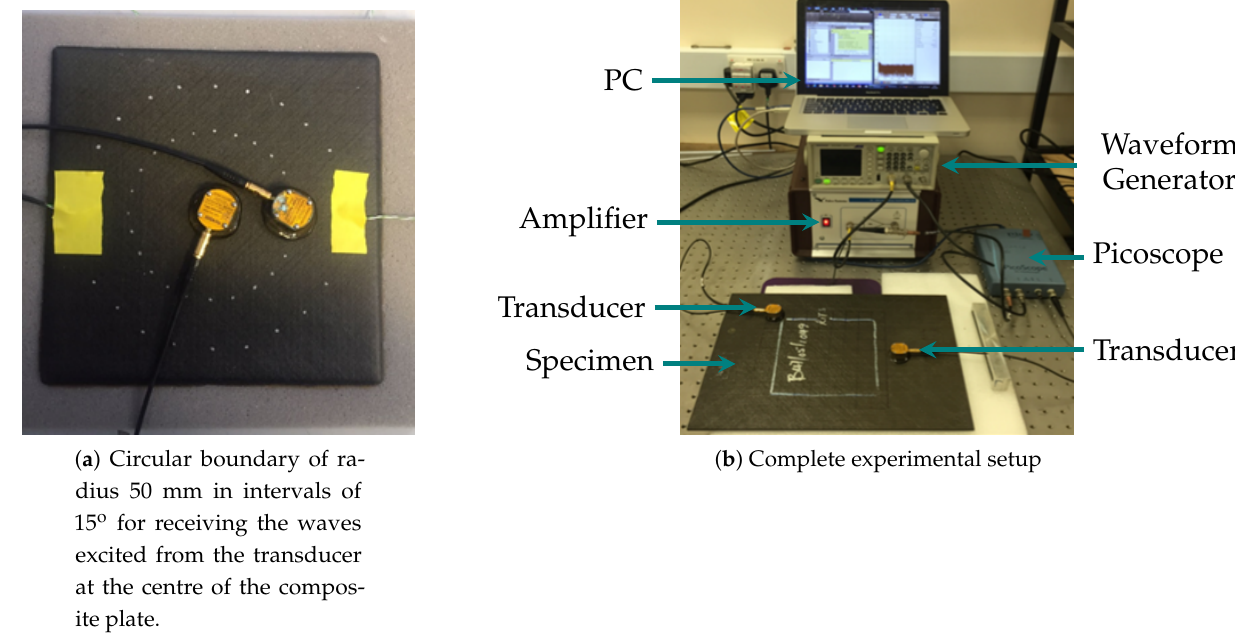
Figure 8. The experimental setup used for determining the group velocity in a composite